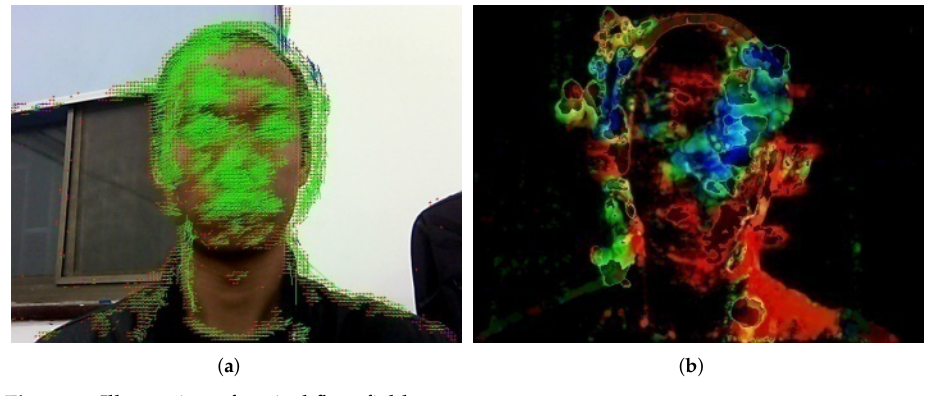
Figure 6. Illustration of optical flow field.